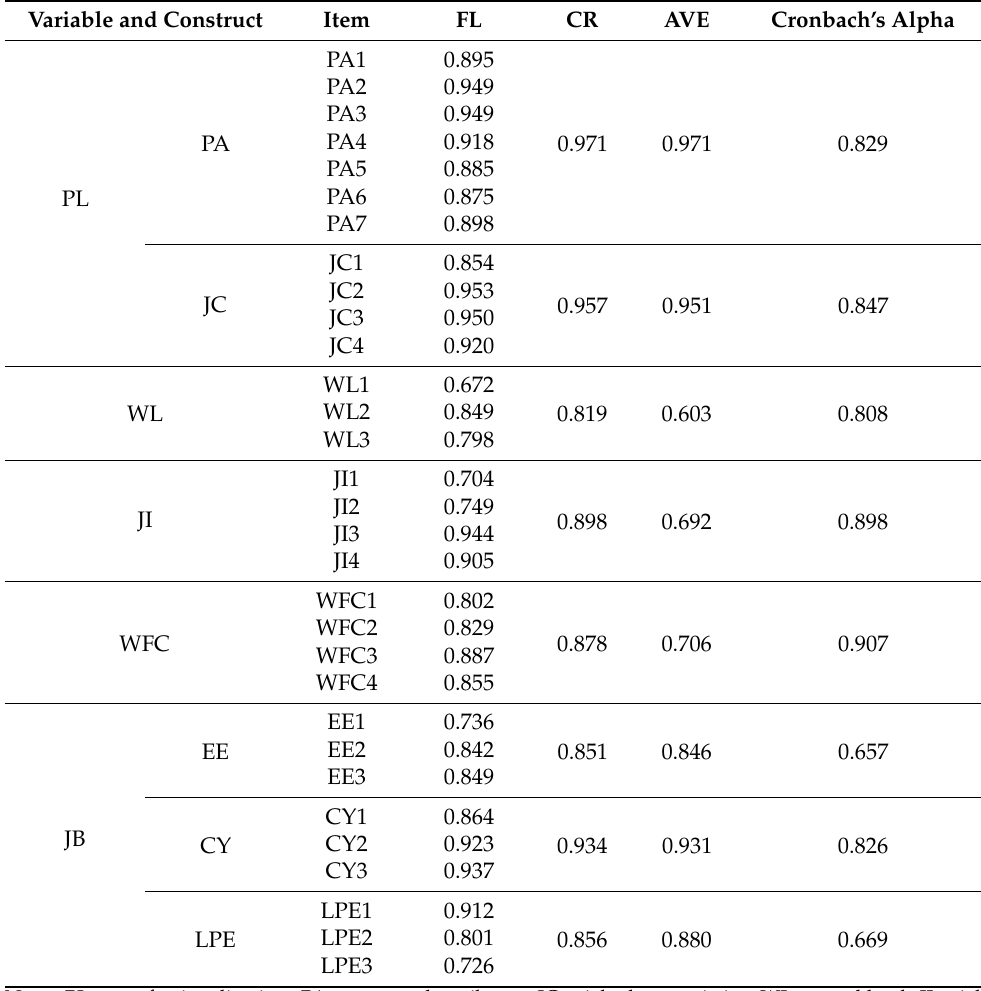
Table 3. Results of reliability and convergent validity for each construct. (N =